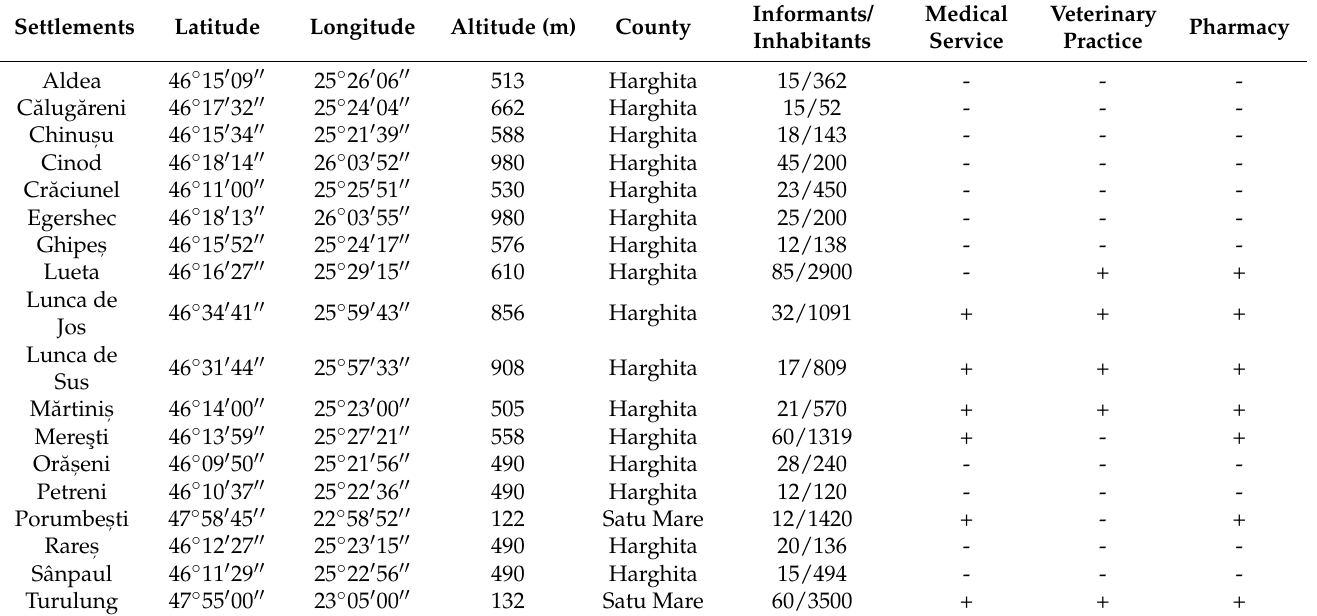
Table 4. Data on the study area in Transylvania (Romania).